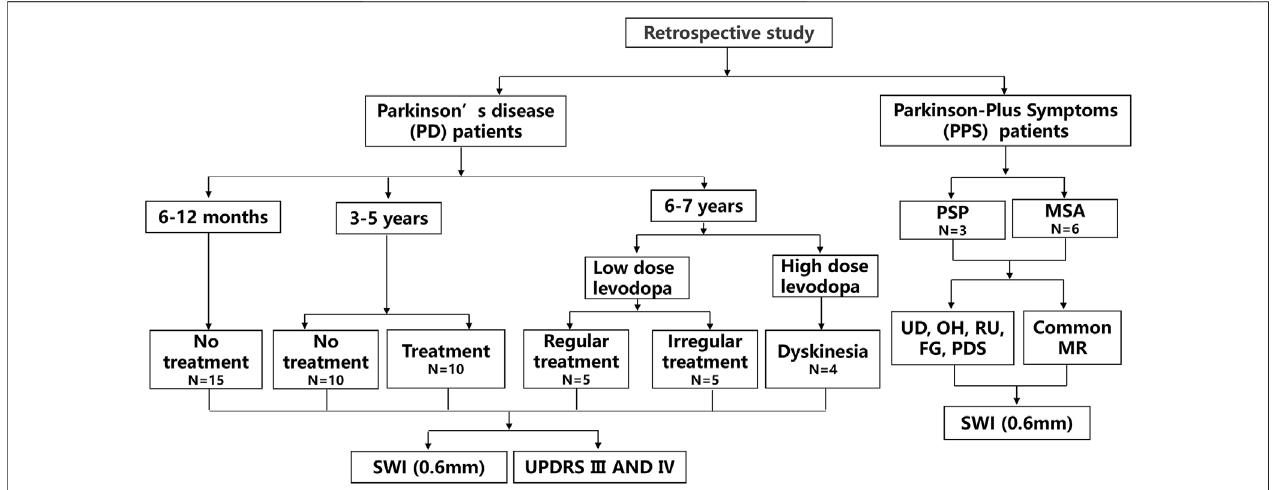
FIGURE 1 | A fl owchart of the study is depicted. Progressive supranuclear palsy, (PSP); supranuclear palsy; multiple system atrophy, (MSA); urinary dysfunction, (UD); orthostatic hypotension, (OH); residual urine, (RU); freezing gait, (FG); Parkinsonism, (PDS); and susceptibility-weighted imaging, (SWI).